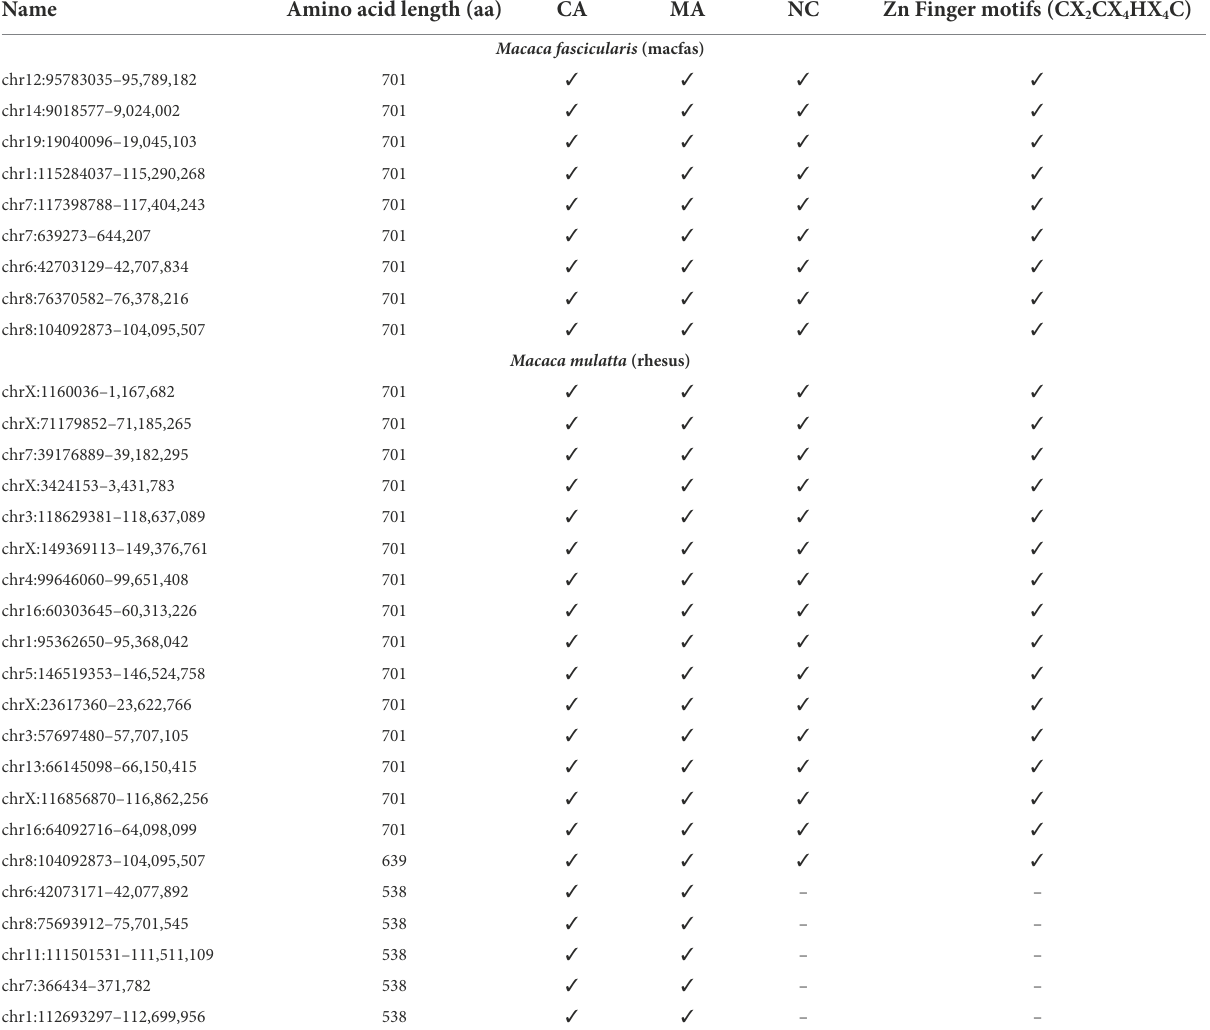
TABLE 3 Presence of structural and functional domains in the potential gag ORFs.